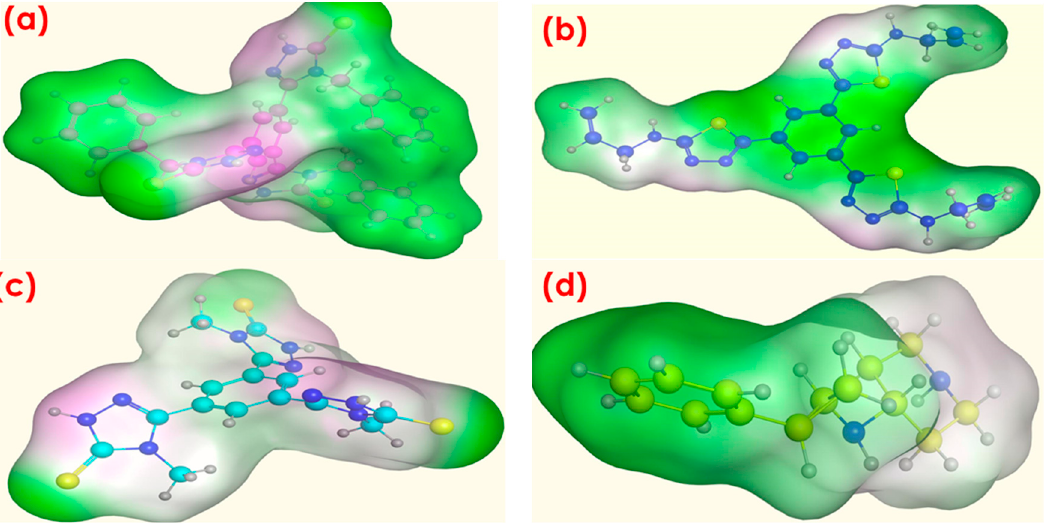
Figure 9. Surface map for the most active derivative ( a ) 22 and ( b ) 27 , ( c ) the least active 18 , and ( d ) the reference compound GSK . Pink, hydrogen bond; blue, mild polar; green, hydrophobic.